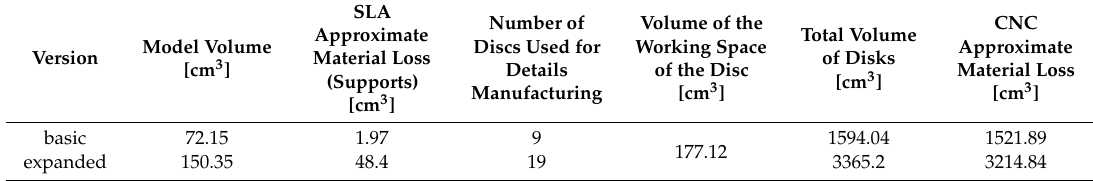
Table 3. Analysis of the consumption of polymer / photopolymer materials in the case of the production of device elements by machining from polymer discs and the SLA method from light-cured